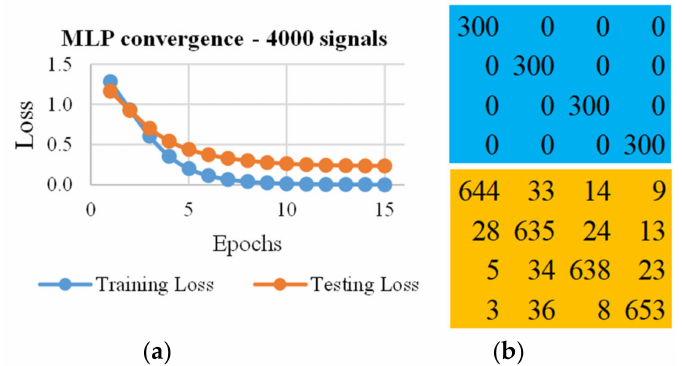
Figure 3. Examples of ( a ) convergence of the first network used, i.e., the multilayer perceptron (MLP), and ( b ) confusion matrixes that express the accuracy of the network (training loss reduction =